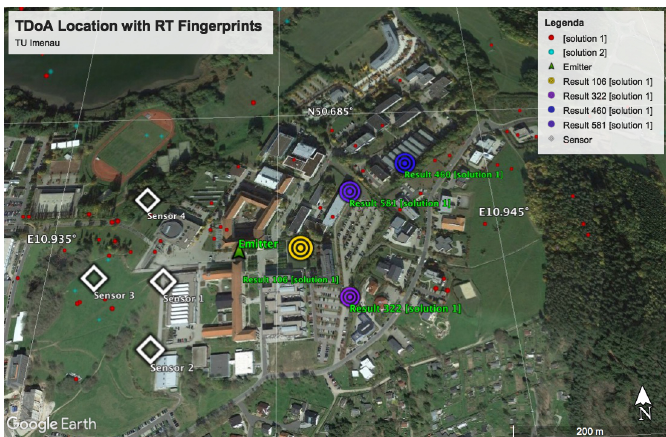
Figure 15. Location error caused by multipath situation in TDOA location.